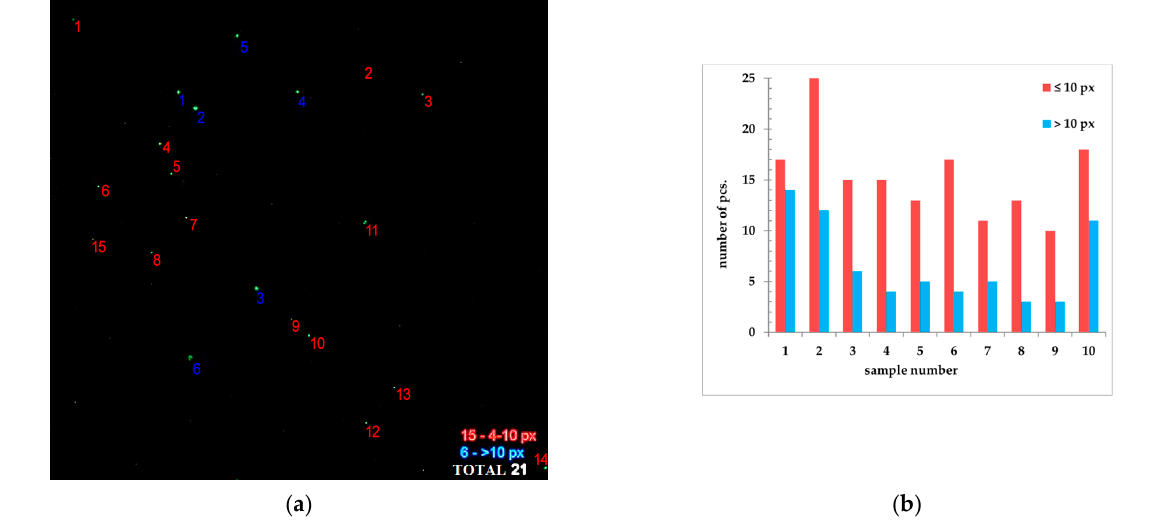
Figure 1. Picture of microplastic particles received using a confocal microscope and ( a ) content of ≤ 10 px and >10 px particles in samples ( b ): ( a ) Microplastic (green) particles are marked with numbers.